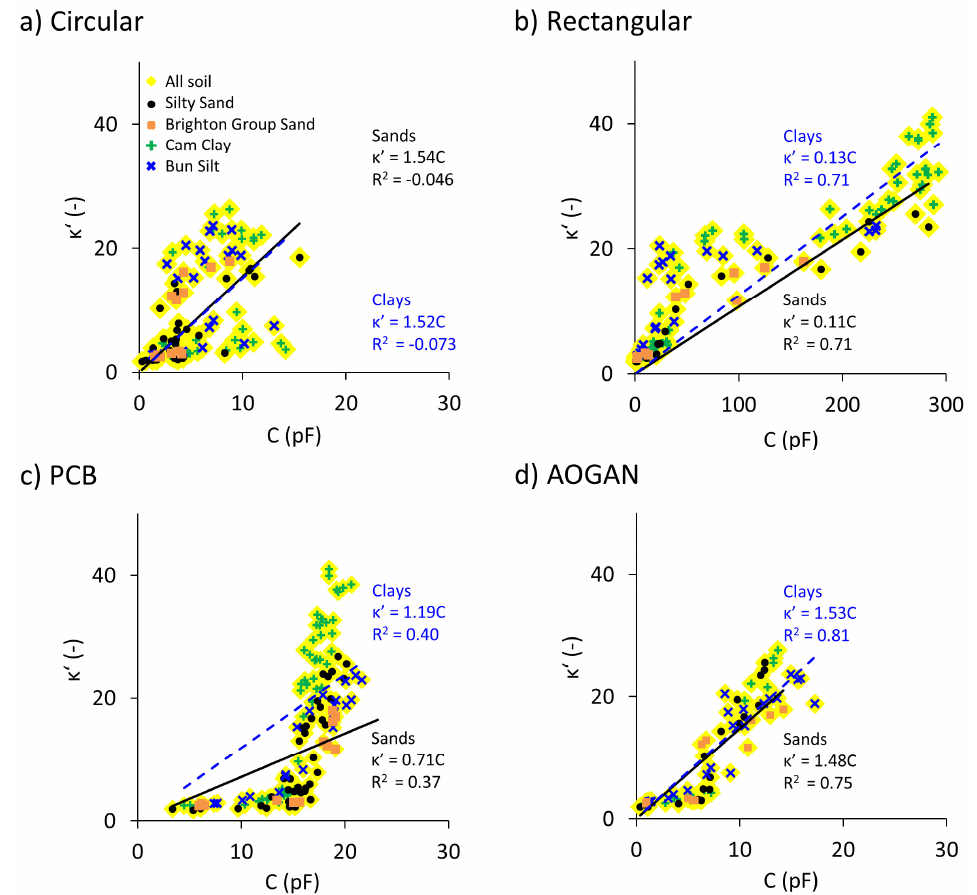
Figure 10. Measured dielectric constant, κ’, data against capacitive, C, readings for the sand (black solid trendline) and clay (blue dashed trendline) groups, for the: ( a ) Circular, ( b ) Rectangular, ( c ) PCB and ( d ) AOGAN sensors.